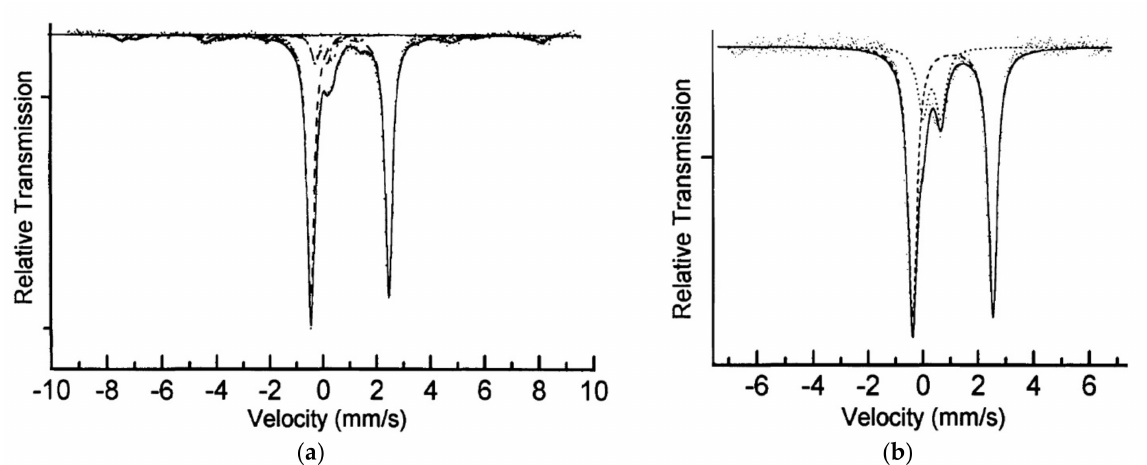
Figure 1. Mössbauer spectra of carbonaceous chondrites: ( a ) Allende CV3 and ( b ) Axtell CV3. Indicated components are the results of the fits. Adapted from Reference